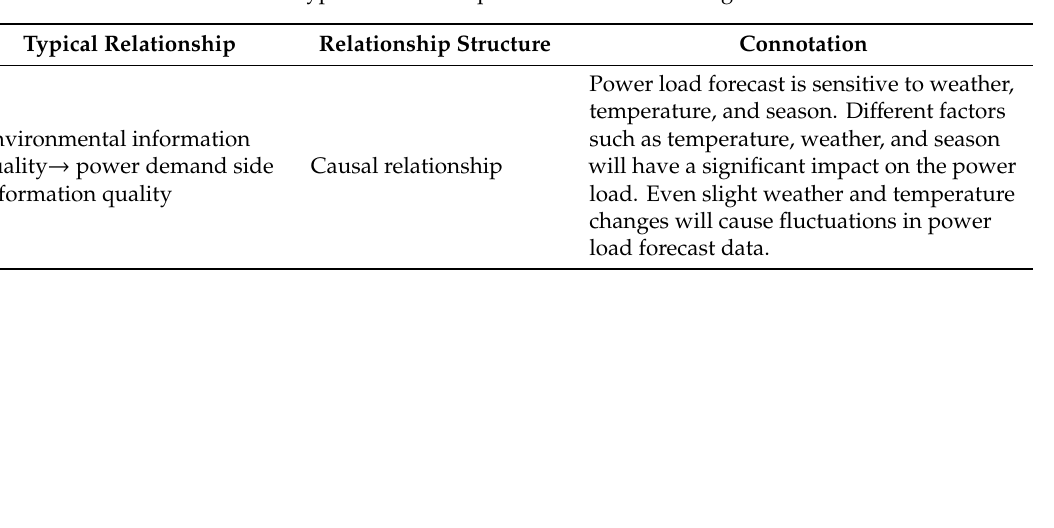
Table 3. Typical relationships structure of main